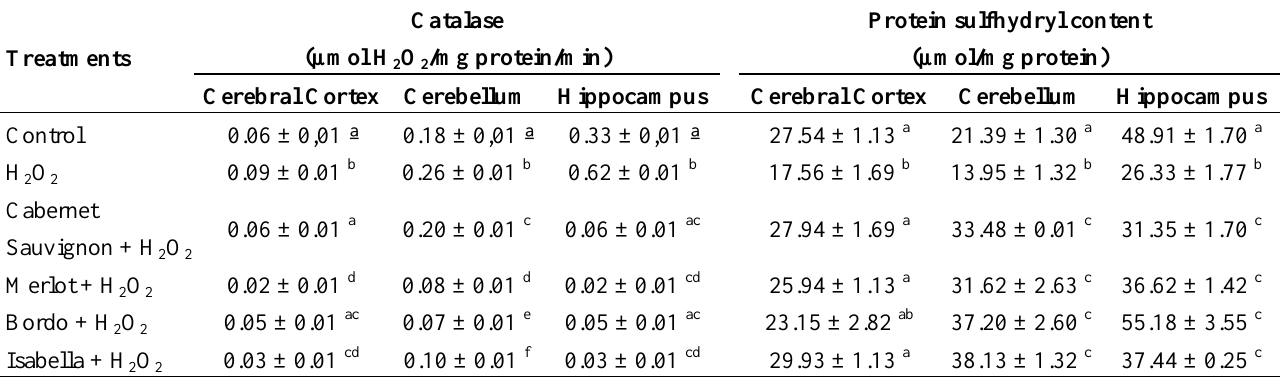
Table 3. Enzymatic and non-enzymatic defenses in cerebral cortex, hippocampus and cerebellum of rats treated with the wine waste extracts plus hydrogen